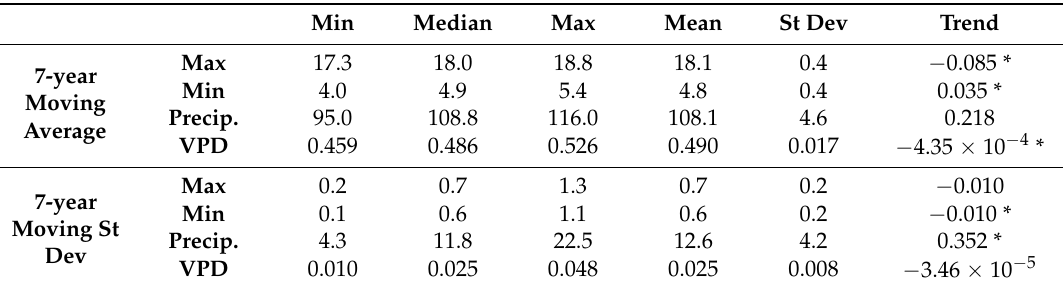
Table 1. Descriptive statistics of moving seven-year averages and seven-year standard deviations of maximum temperature ( ◦ C), minimum temperature ( ◦ C), and precipitation (cm) in West Virginia, USA. The slope (change per decade) of linear regressions were